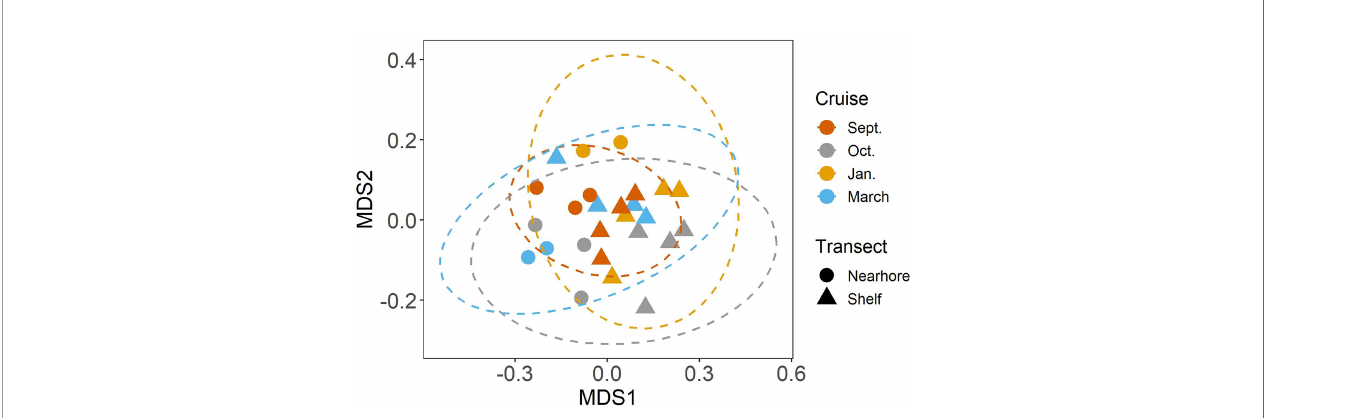
FIGURE 3 | NMDS analysis of mesozooplankton community structure. Colors indicate cruise month. Ellipses represent 95% CI (Solid lines = signi fi cant differences in community structure from PERMANOVA, p < 0.05).